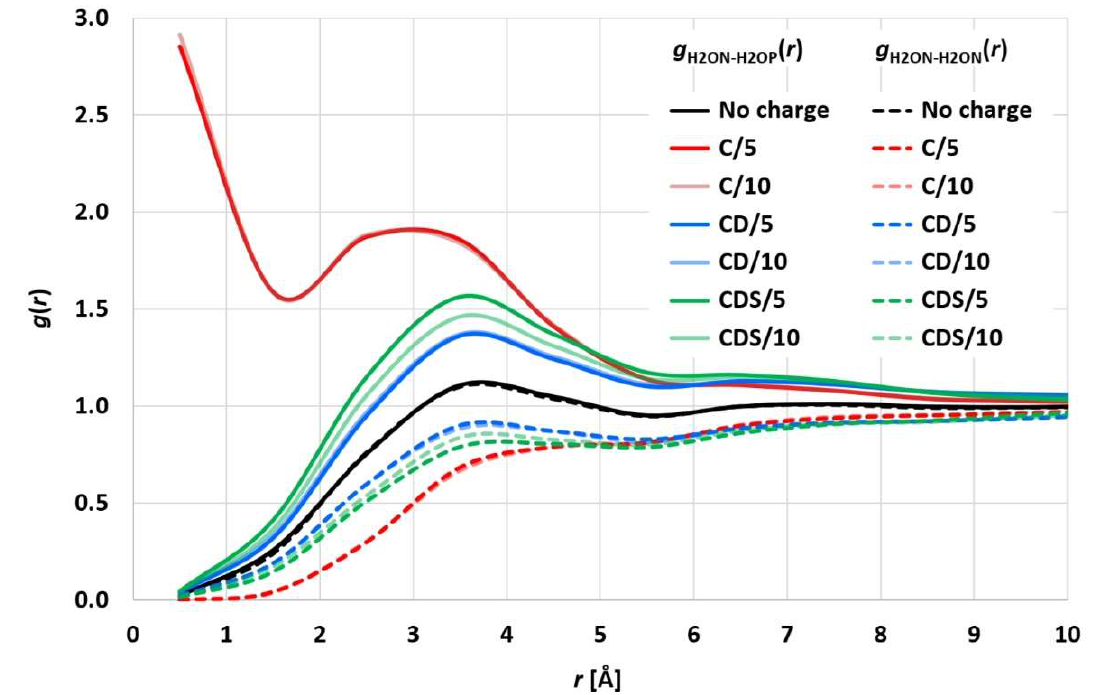
Figure 2. Particle–particle radial distribution functions of the pure water system with H2ON-H2OP or H2ON-H2ON ion pairs for the different approaches (C, CD, CDS) and different electrostatic cut-off radii (5 or 10 reduced DPD length units).